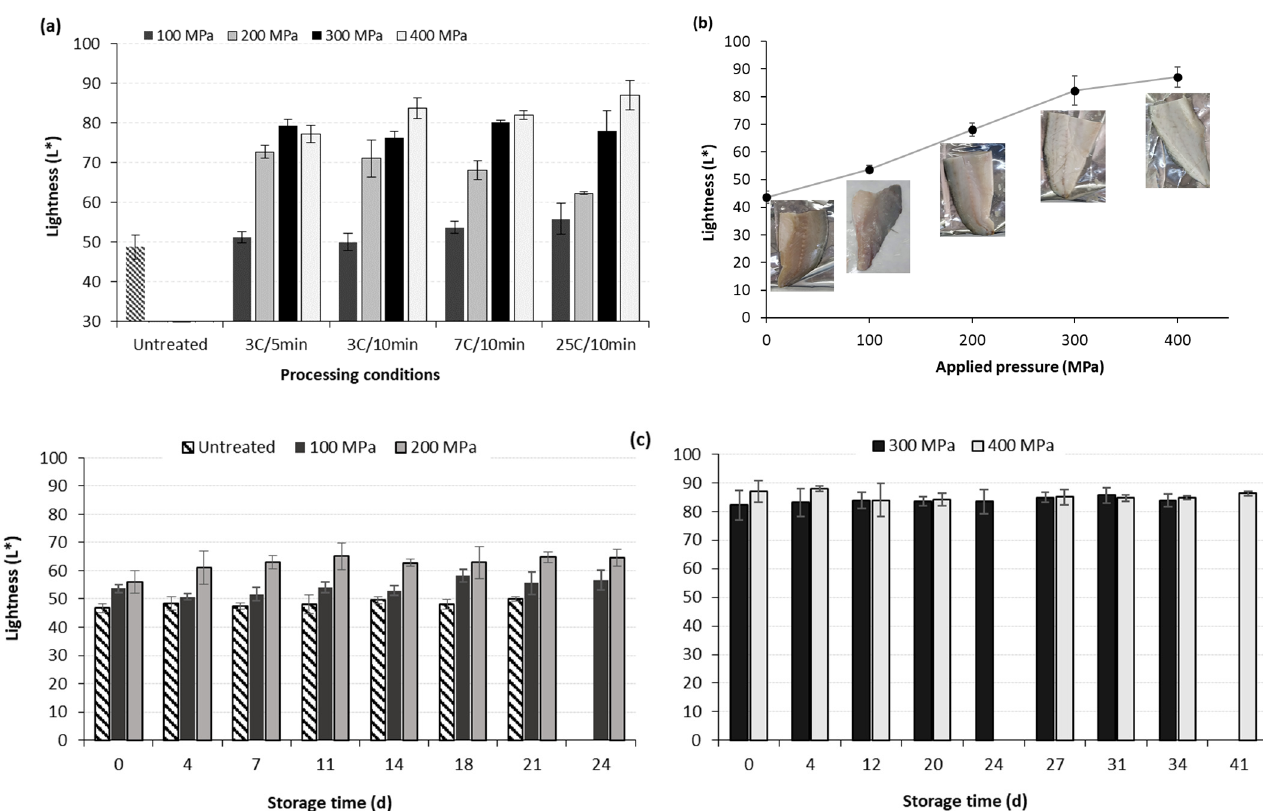
Figure 3. ( a ) Values of lightness (L*) of untreated European sea bass fillets and after HP processing at different pressure–temperature–time conditions, ( b ) visual appearance compared to lightness (L*) values of untreated and HP-treated fish fillets, and ( c ) evolution of lightness (L*) during storage for fish samples treated at different pressure levels at 25 °C for 10 min. Each bar shows the mean and the standard deviation of four replicates ( n = 4).